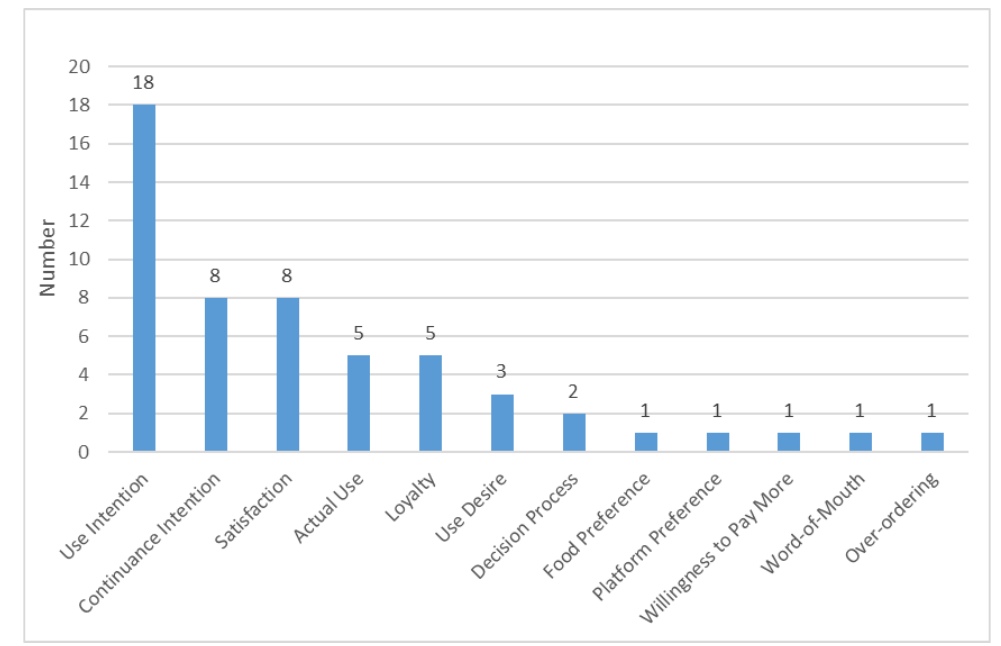
Figure 3. Key dependent variables.